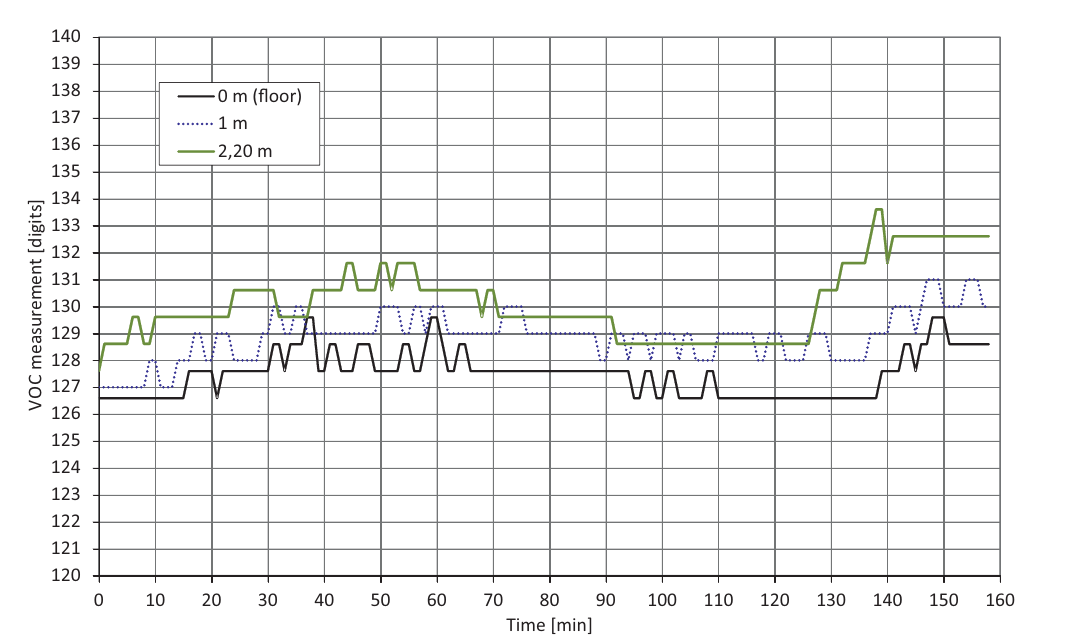
Figure 3. VOC signal at different heights in an office